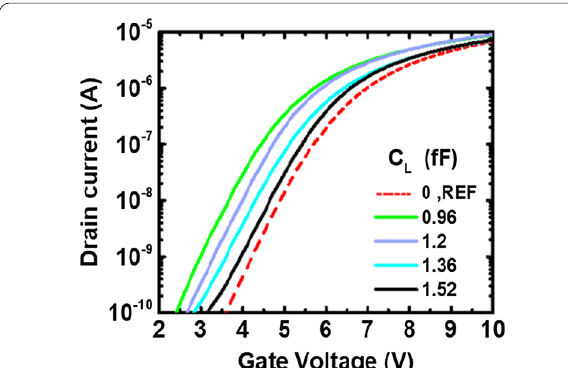
Fig. 10 Comparison of the average Δ V t versus C L implemented by 10. When = the three types of capacitor structures, where Δ V t is defined as the V t difference between a detector cell and the reference cell. Data suggest that reduced sensitivity can be obtained as C L